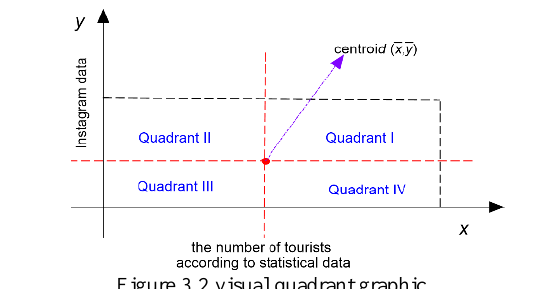
Figure 3.2 visual quadrant graphic